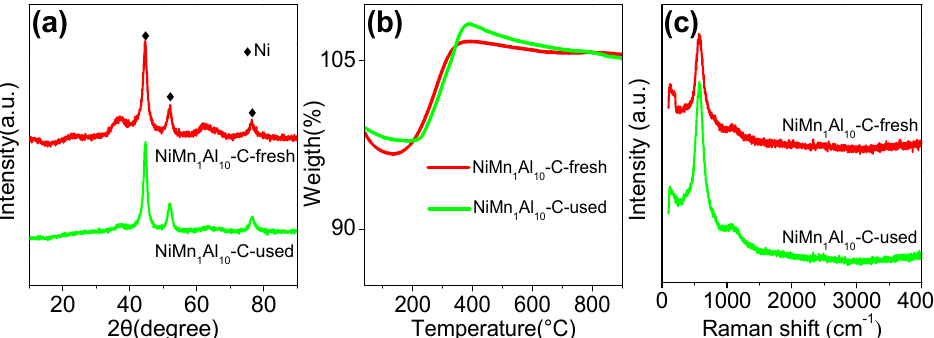
Figure 11. XRD ( a ), TG ( b ) and Raman spectrum ( c ) of the catalysts.